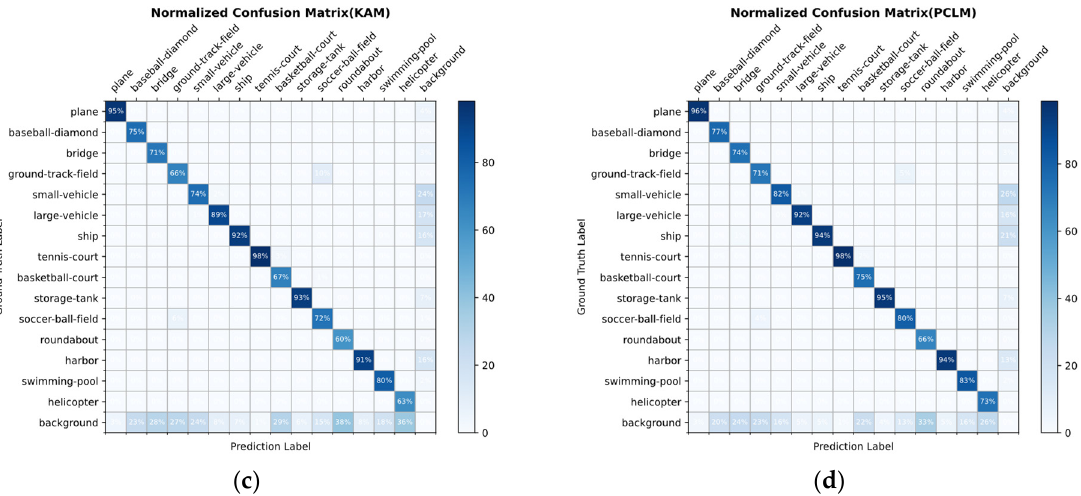
Figure 9. Normalized confusion matrix for ablation experiment on the DOTA1.0 dataset. ( a ) Baseline. ( b ) Baseline + EMFL. ( c ) Baseline + KAM. ( d ) Baseline + PCLM.